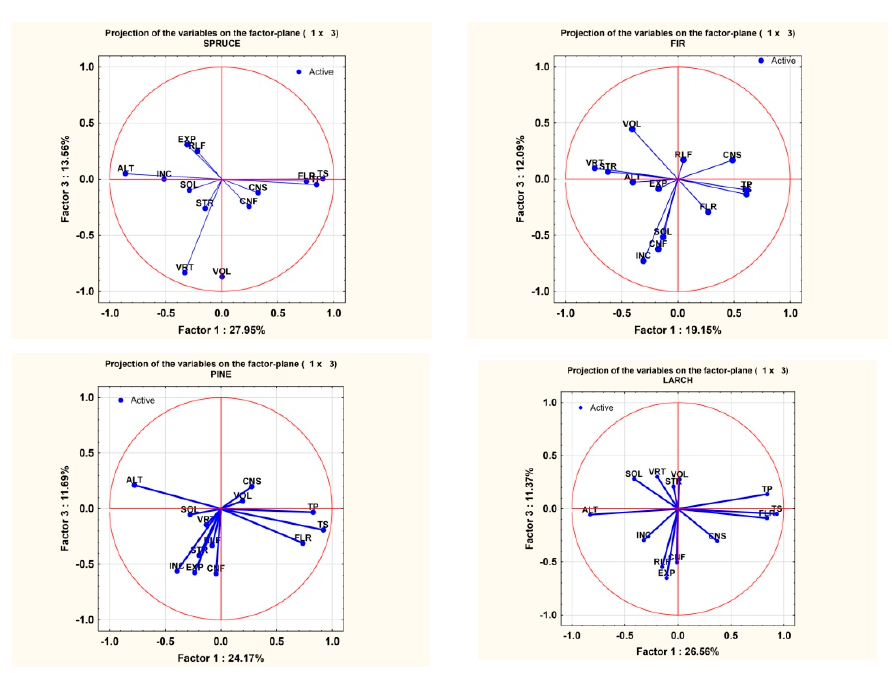
Figure 8. PCA diagram for factors 1 and 3.